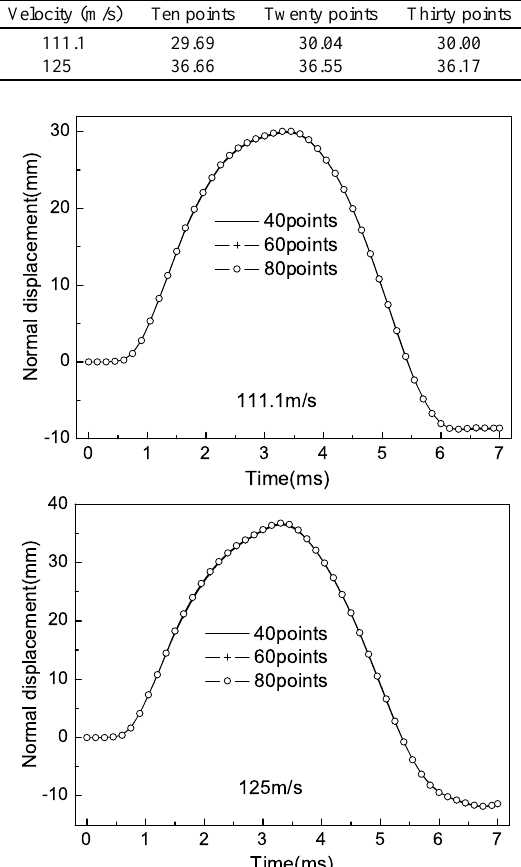
Table 6 The maximal normal displacement at the center on inner surface for different mesh seeds along central axis of bird (unit: mm)